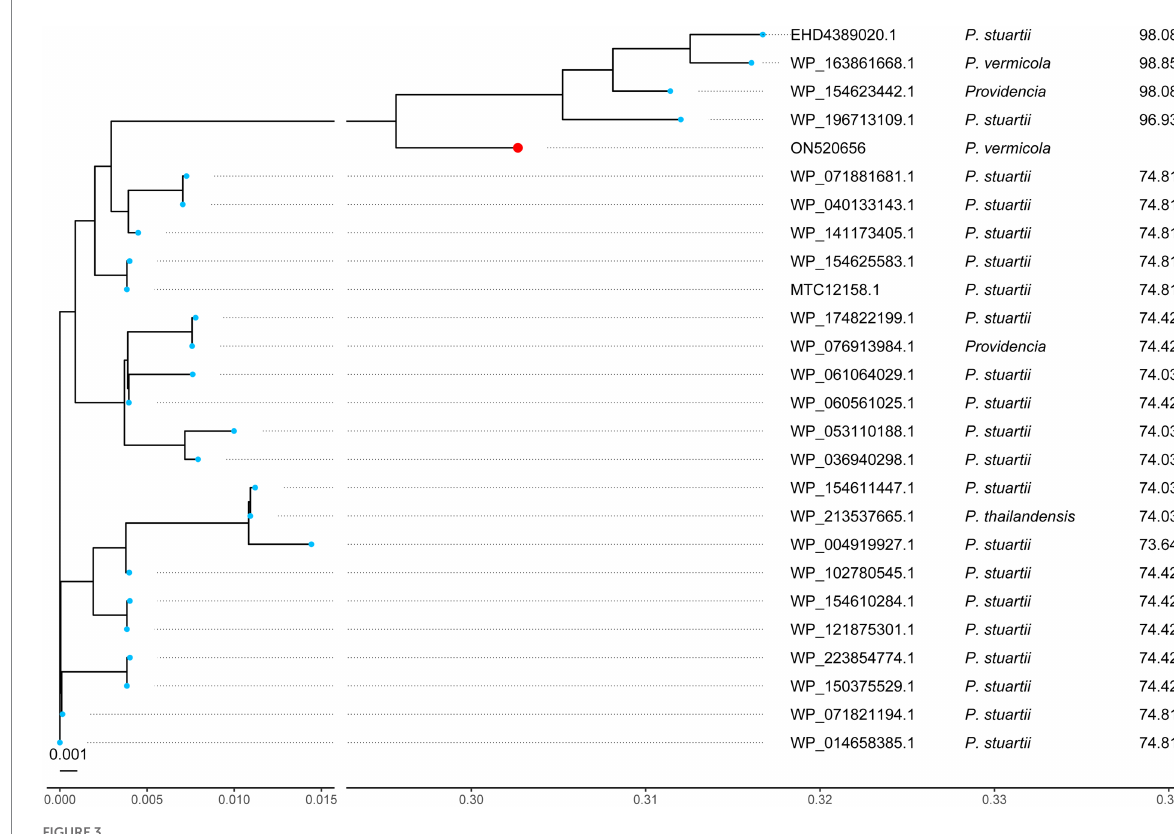
O -nucleotidyltransferase AadA31. The novel